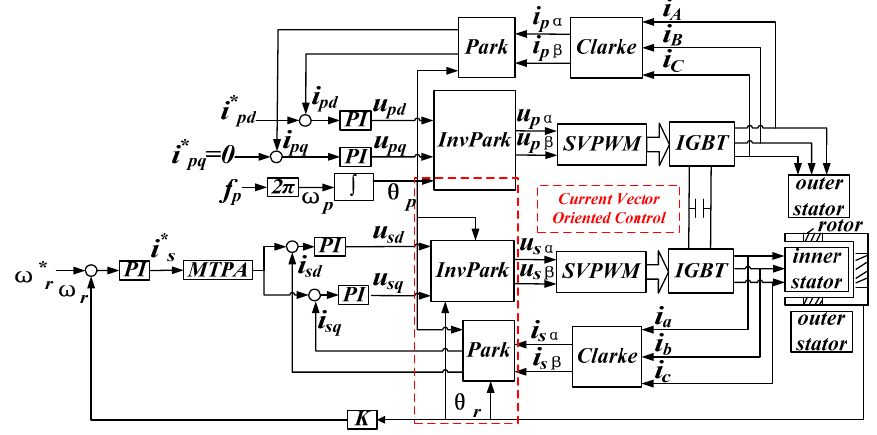
Figure 13. AC excitation control method.